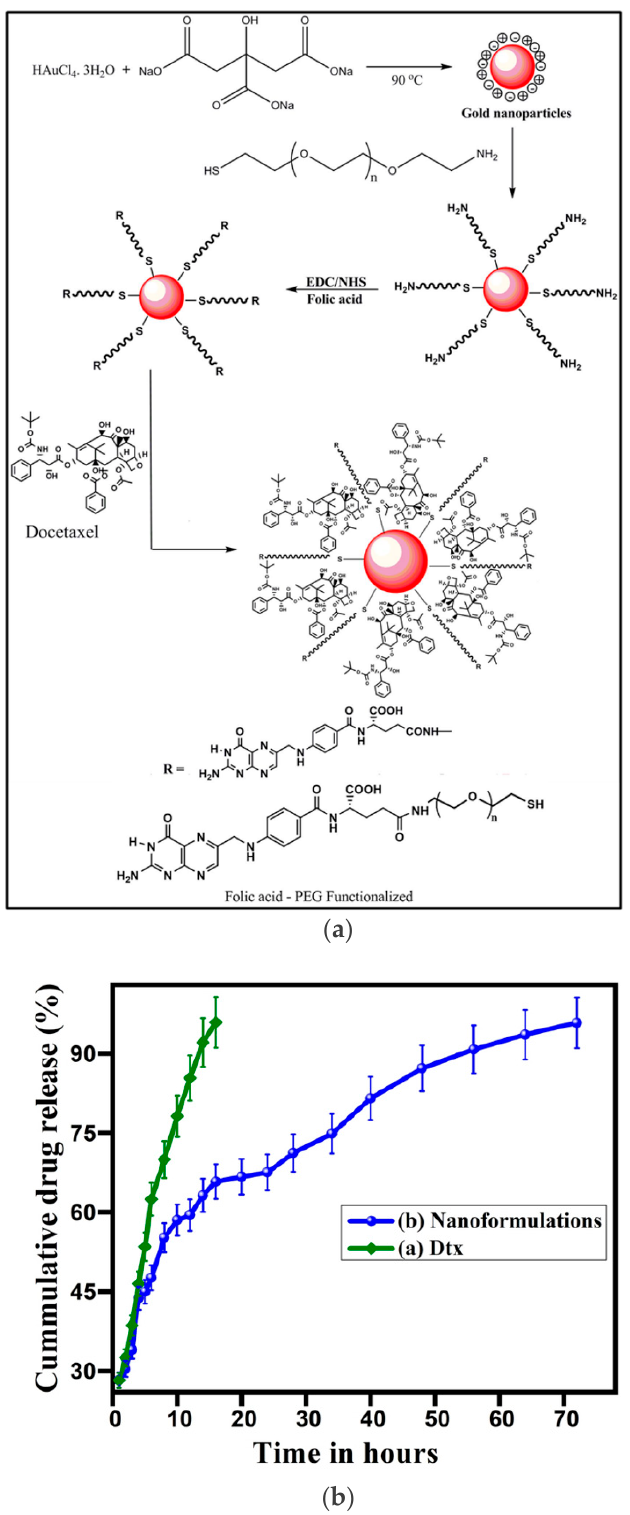
Figure 10. Use of GNPs for delivery of DTX. ( a ) Mechanism for the synthesis of DTX incorporated GNPs. ( b ) In vitro drug release profile of ( a ) DTX and ( b ) gold nano-formulations in PBS solution at pH 7.4. Reproduced from [94], Springer Nature, 2021.